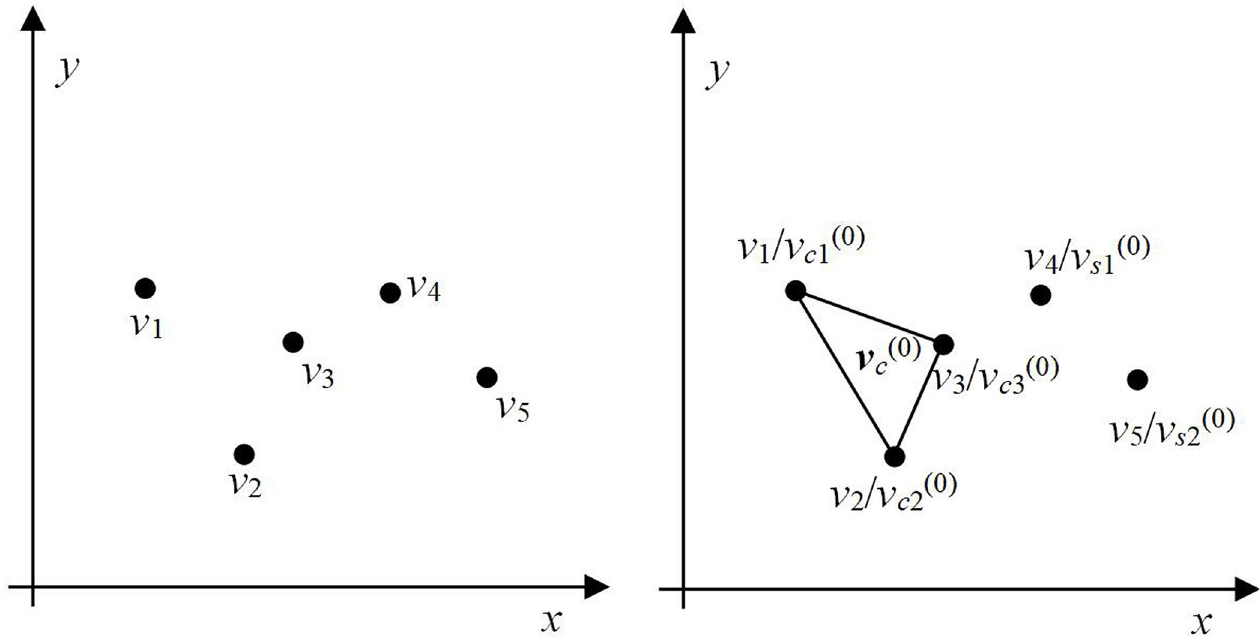
Fig 5. Example of polygon initialization. (a) Random point distribution and (b) polygon initialization.